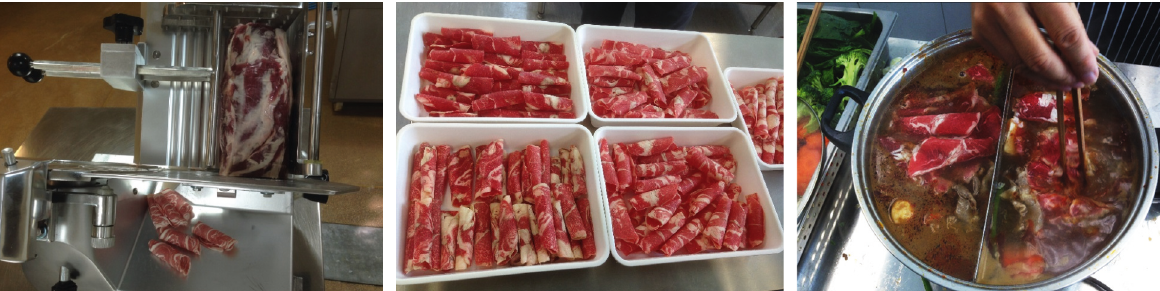
Figure 1: Stages of hotpot meat production and consumption. (a) Restructured/formed hotpot beef log being sliced using a hotpot slicer; (b) rolled hotpot slices ready for cooking; (c) hotpot meat pieces being dipped in a simmering hotpot